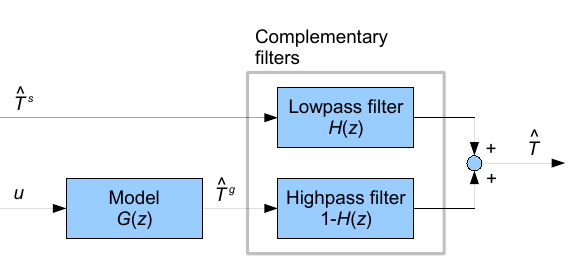
Figure 3: Basic principle of the sensor fusion algorithm.